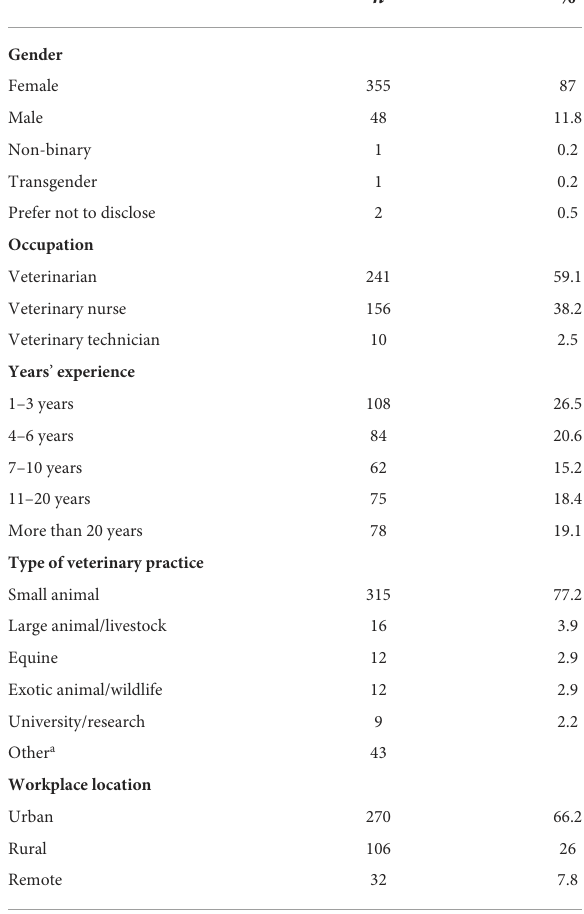
TABLE 1 Sociodemographic characteristics of participants ( n =